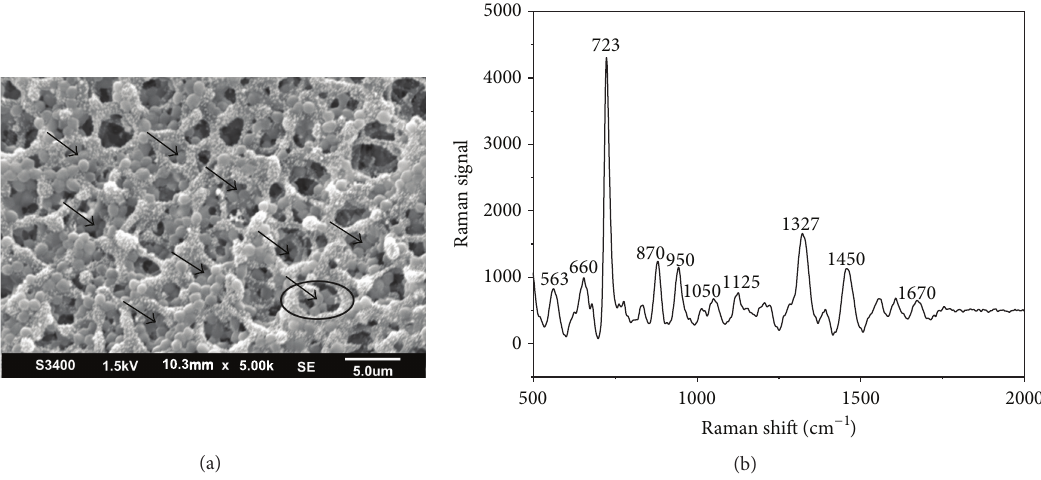
Figure 5: (a) Representative scanning electron microscopy image of Staphylococcus aureus trapped in the porous silver nanoparticles membrane; (b) surface enhanced Raman scattering spectra of Staphylococcus aureus when 𝐵 in = 0.683 ( 𝐵 in is the ratio of Staphylococcus aureus trapped inside the micropores).